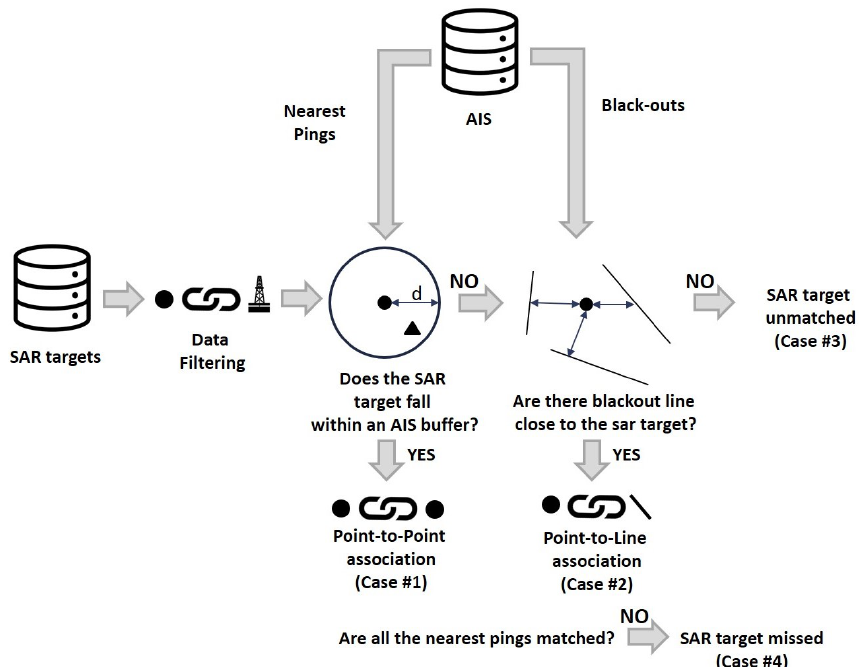
Figure 5. AIS-SAR Matching Algorithm.